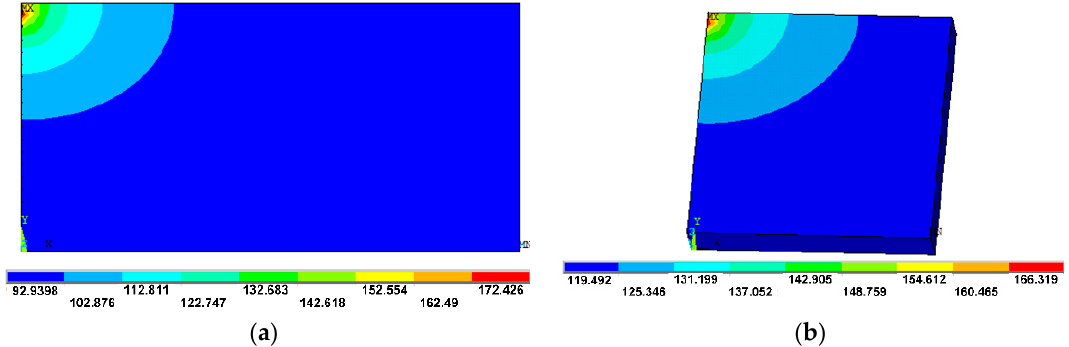
Figure 10. Temperature distribution in different part size (°C). ( a ) Large-size model; ( b ) small-size Figure10. Temperaturedistributionindi ff erentpartsize( ◦ C).( a )Large-sizemodel; ( b model.